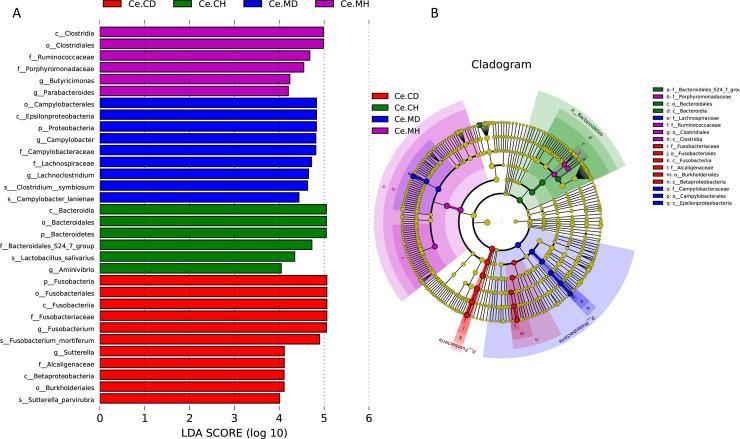
Differentially abundant microbes and taxons identified by LEfSe and the cladogram for each group.LEfSe identified taxons for Ce.CH, Ce.CD, Ce.MH and Ce.MD. (Left) Histogram of the LDA scores computed for features differentially abundant of cecal microbiota among healthy and diarrheal piglets. (Right) Taxonomic cladogram representation of statistically and biologically consistent differences of cecal microbiota among healthy and diarrheal piglets. Only taxa meeting an LDA significant threshold >4 are shown.